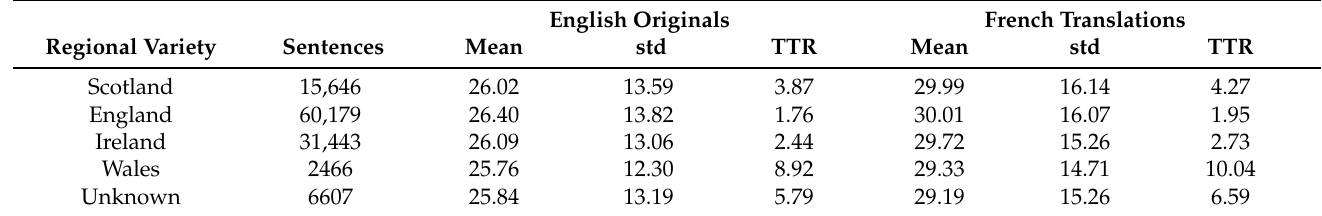
Table 1. Extracted statistics: mean and standard deviation sentence length, and type-token ratio (TTR). Both TTR and average sentence length are statistically significant under a permutation test, with p -value < 0.01 for original English documents from Scotland, pair-wise for: England vs. Scotland and Ireland vs. Scotland. English Originals French Translations Regional